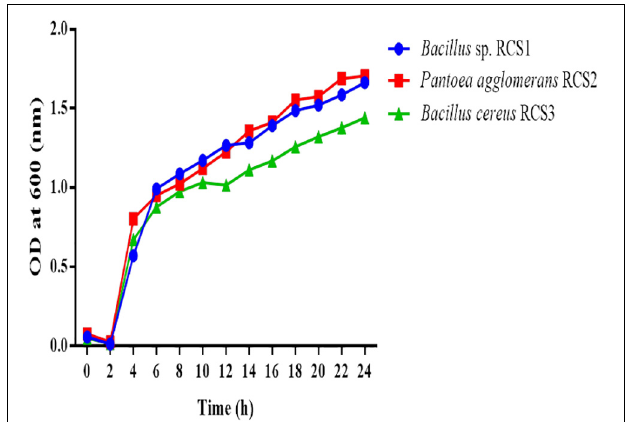
FIGURE 3 | Bile endurance of bacteria after 4 h at 37 ◦ C. Values are presented as mean ± SE. Different letters show significant differences ( P < 0.05).